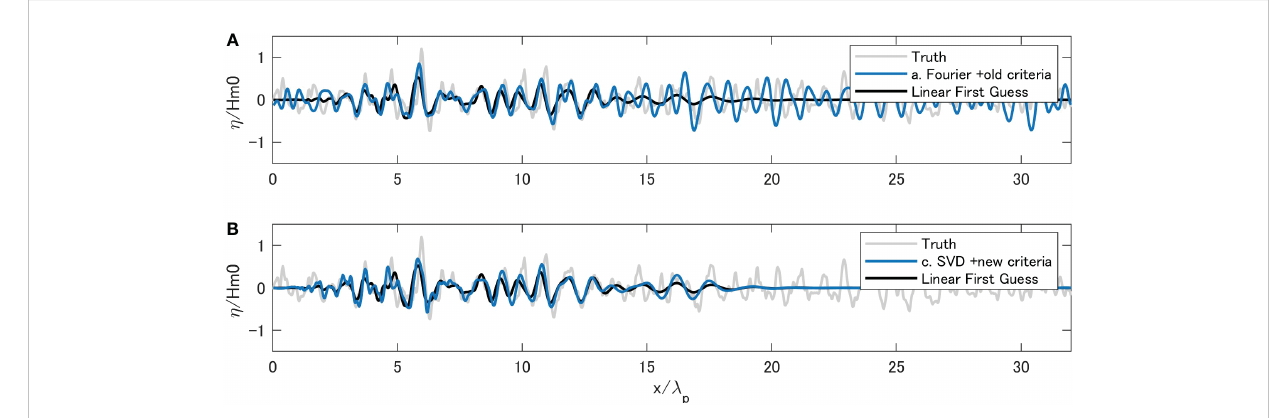
FIGURE 7 The analyses of SWEAD (a) and SWEAD-S variant (c) are compared to the truth and the linear fi rst guess in panel (A, B) , respectively.